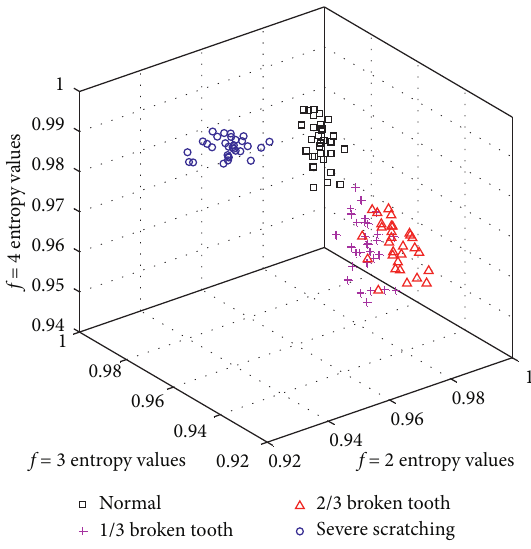
Figure 7: The 3D map of MPE-PCA.